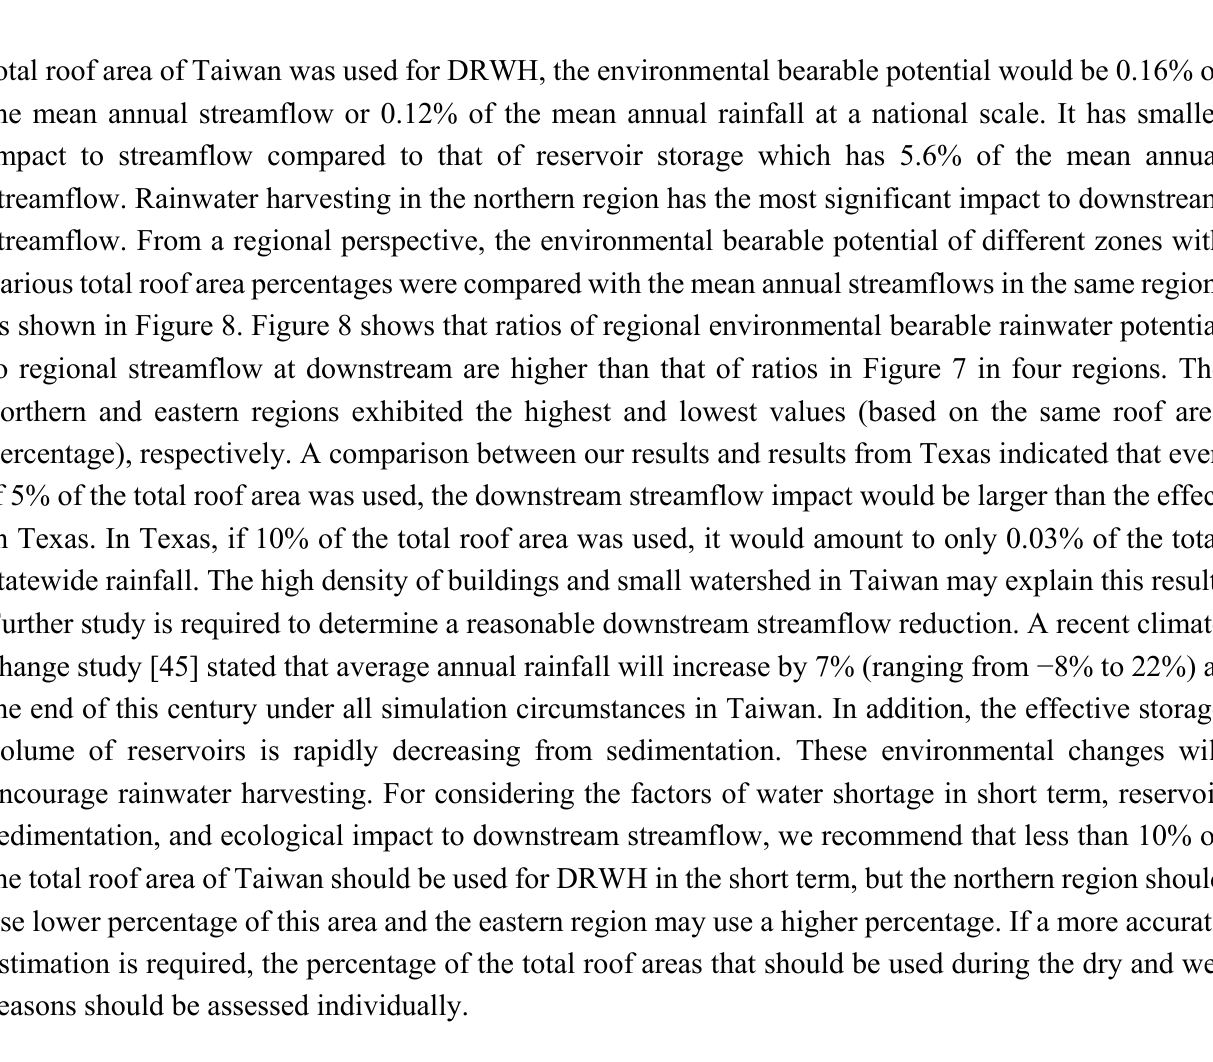
Figure 7. Environmental bearable rainwater potential compared to streamflow at downstream for selected percentages of total roof area for national-wide and four